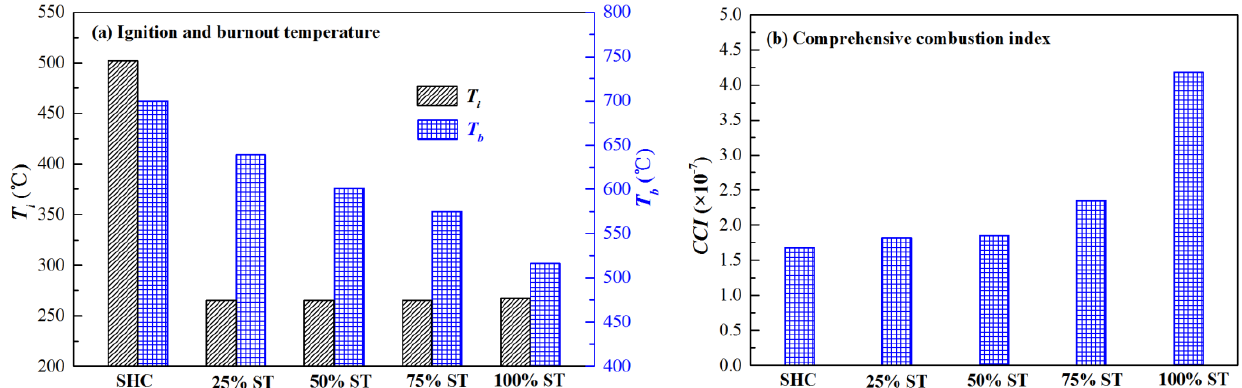
Figure 3. Ignition and burnout temperatures, CCI under different ST blending ratios (20 °C/min, 21% O 2 /79% CO 2 ).